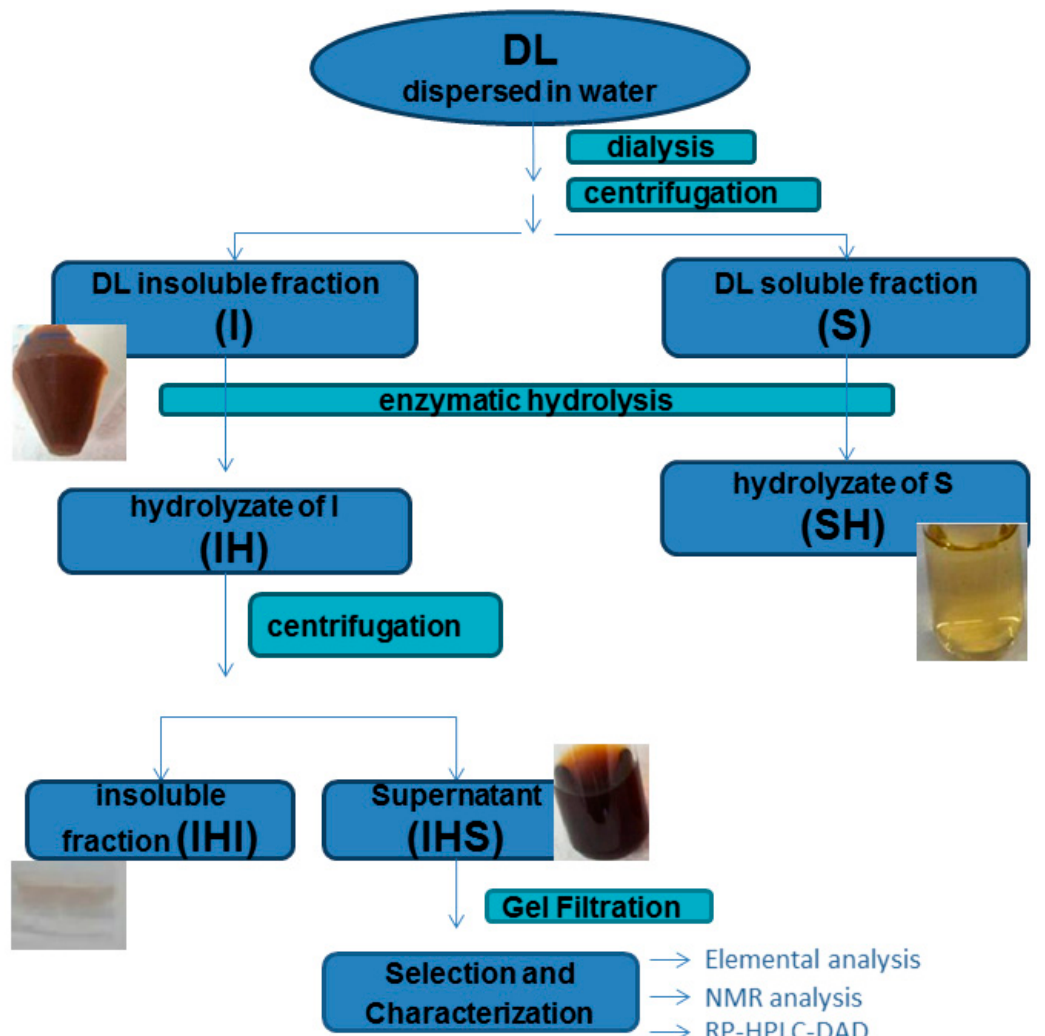
Figure 1. Diagram of the fractionation and isolation of di ff erent components from dulce de leche (DL), including the product after enzymatic hydrolysis of the DL soluble fraction (SH), the DL insoluble fraction (I), the soluble fraction after enzymatic hydrolysis of I (IHS), and the insoluble fraction after enzymatic hydrolysis of I (IHI).